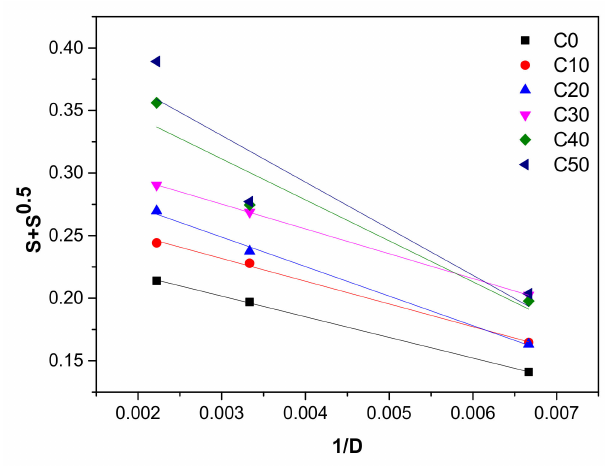
Figure 6. Charlesby–Pinner plots of NR/PS